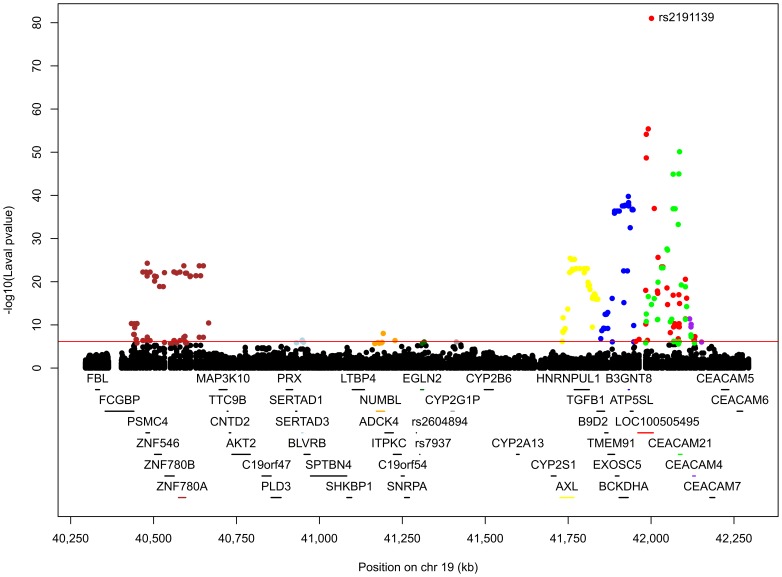
Lung eQTLs on 19q13 in the Laval dataset.Each dot represents an association test between one SNP and one probeset. Only dots above the red line are significant (p<7.1×10−7). Significant SNPs were regulating the expression levels of ZNF780A in brown, SERTAD3 in light blue, NUMBL in orange, EGLN2 in dark green, CYP2G1P in dark grey, AXL in yellow, B3GNT8 in blue, LOC100505495 in red, CEACAM21 in green, and CEACAM4 in purple. The SNP with the smaller p-value is indicated. SNPs previously associated with COPD are illustrated at the bottom.